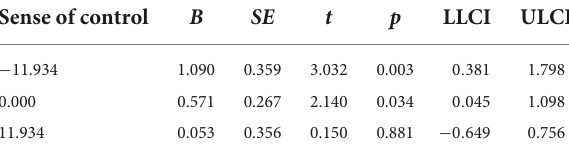
TABLE 4 Conditional effects of perceived susceptibility at values of sense of control.